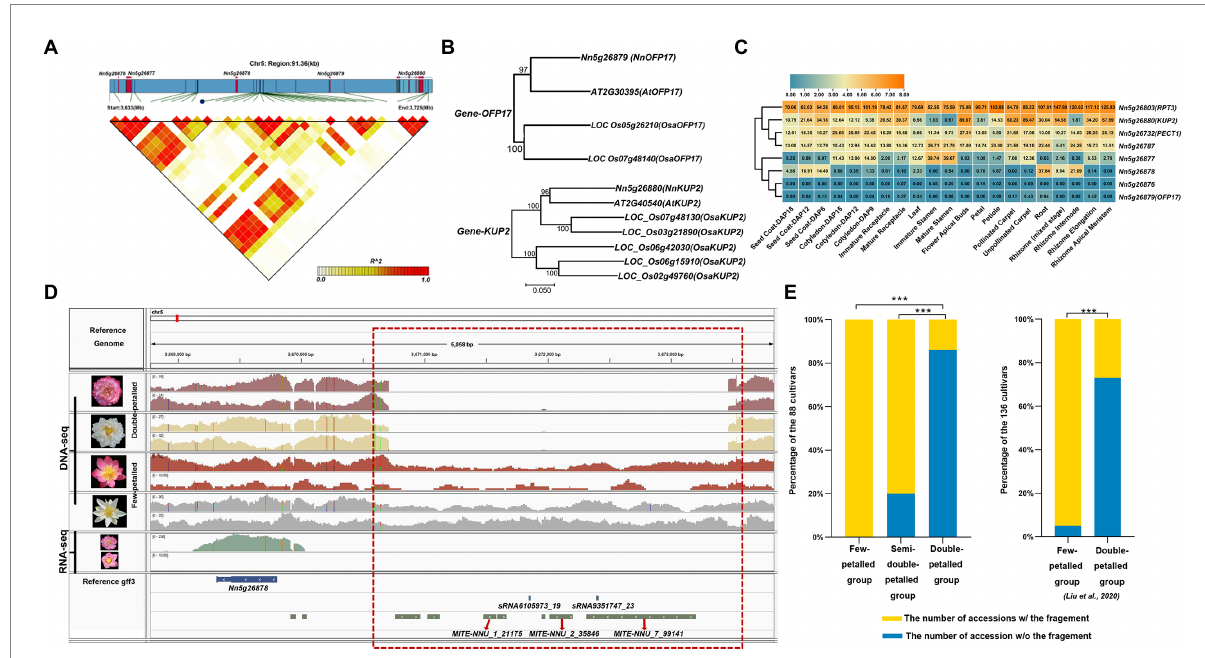
FIGURE 4 The candidate genes associated with flower types and stamen petaloid. (A) The regions of low-to-high LD, measured by the r 2 statistic, are represented by a color gradient. (B) The two phylogenetic trees of candidate orthologous genes ( OFP17 and KUP2 ) associated with flower types between lotus ( Nn ), Arabidopsis ( At ) and Oryza sativa ( Osa ). And the neighbor-joining (NJ) trees with 500 bootstrap replicates was constructed by MEGA 7.0. Numbers at nodes indicate bootstrap values. (C) Heatmap and hierarchical clustering of the candidate genes showing the expression pattern in different tissues. (D) Integrative genomics viewer displaying the long-gap variant (chr5: 3,670,710-3,673,465, area within the red box) near a candidate gene with differential expression between few-petalled and double-petalled lotus. (E) The proportions of lotus accessions with genomic fragments that are completely deleted (blue) or present (yellow) in the region (3,670,710–3,673,465 on chromosome 5) out of the 88 lotus individuals examined in our study (left panel) and the 136 lotus accessions with high-depth resequencing datasets from Liu et al. (2020) (right panel) based on Illumina read coverage (***, value of p <